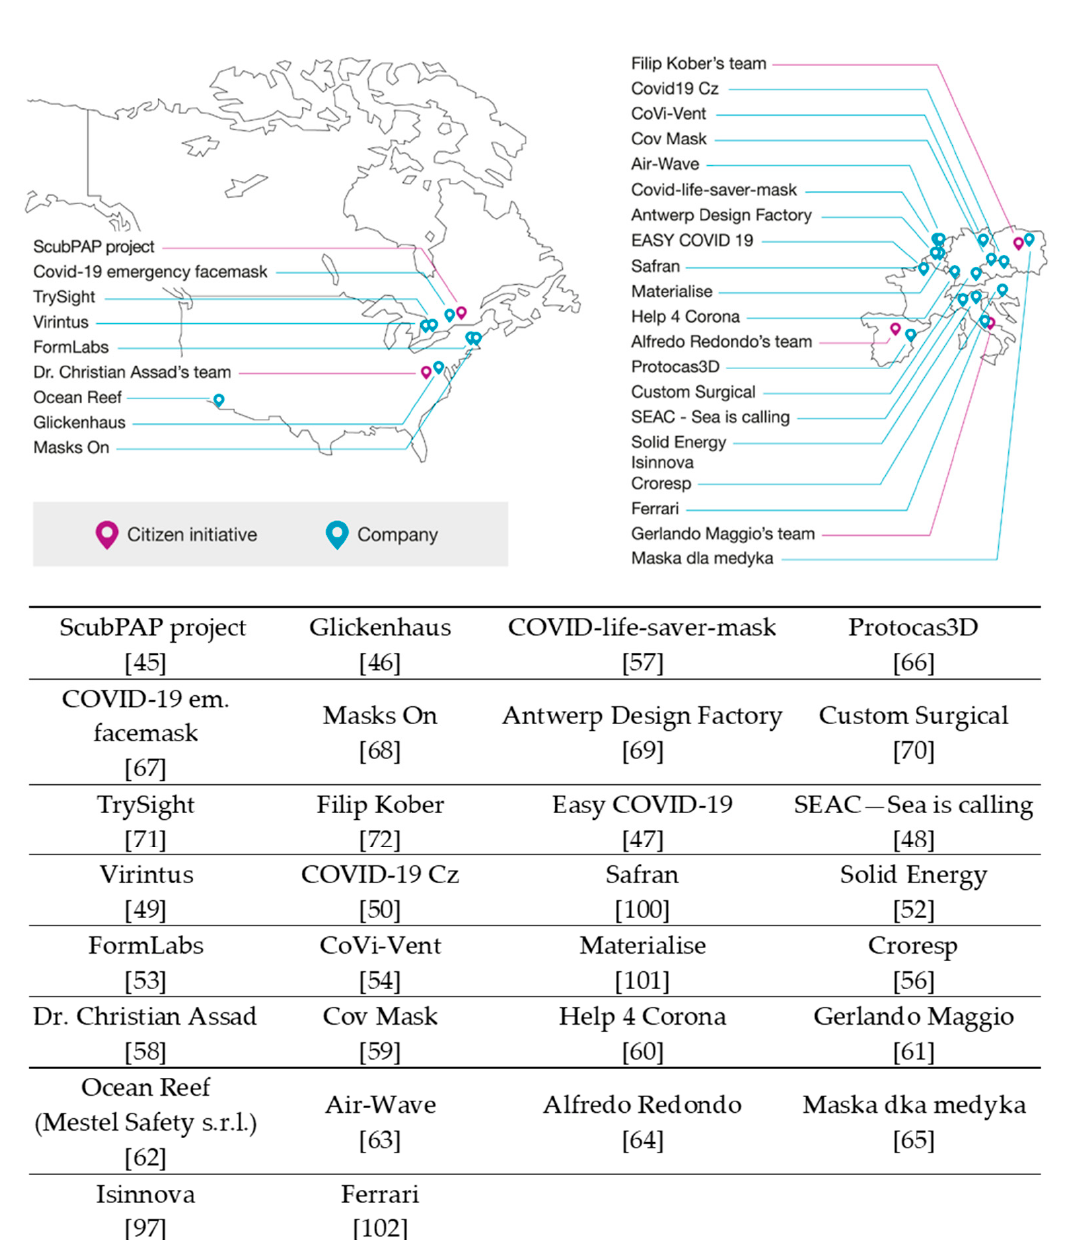
Figure 5. World map representing different initiatives in North America and Europe for manufacturing ecosystems for modified mask (MM) fabrication for use in healthcare institutes during the supply shortage in the first wave of the COVID-19 pandemic [45–50,52–54,56–72,97,100–102].